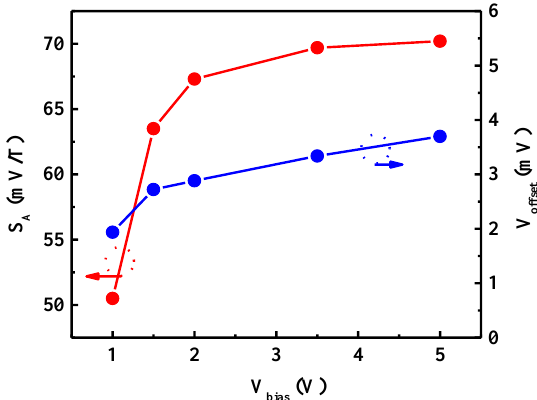
Figure 3. Diagram of absolute sensitivity S A and offset voltage V offset of the FD-SOI Hall sensor under different voltage biases V bias . V bias defines the sensitivity/offset voltage trade-off that must be properly adjusted based on the application constraints.